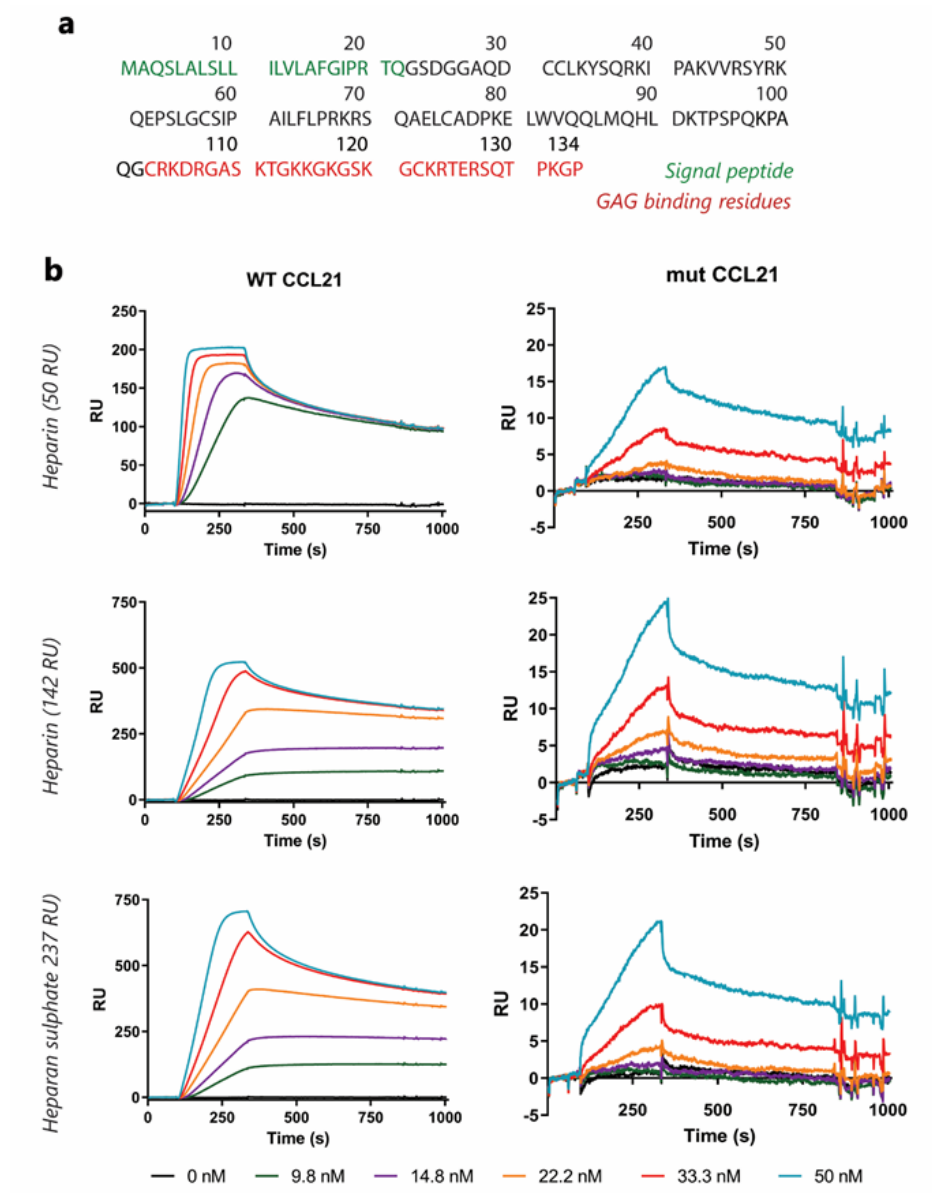
Figure 3. 3 Generation and characterisation of non-glycosaminoglycan binding CCL21 ( a ) CCL21 chemokine amino acid sequence. In order to create a non-HS binding CCL21, residues Δ 103–134 (marked in red as the glycosaminoglycan binding domain) were eliminated from the C-terminal of CCL21 WT. The signal peptide (marked in green) will not be present in the mature protein. ( b ) Surface plasmon resonance (SPR) assay. Gold-coated Biacore chips were used to assess the alteration in GAG binding in mut-CCL21 as compared to the WT. (top) 0–50 nM chemokine flowed over immobilised heparin (50 RU bound) and the alteration in resonance units (RU) was recorded. (middle) 0–50 nM chemokine flowed over immobilised heparin (142 RU bound) and the alteration in resonance units (RU) was recorded. (bottom) 0–50 nM chemokine flowed over immobilised heparan sulphate (237RU bound) and the alteration in resonance units (RU) was recorded.